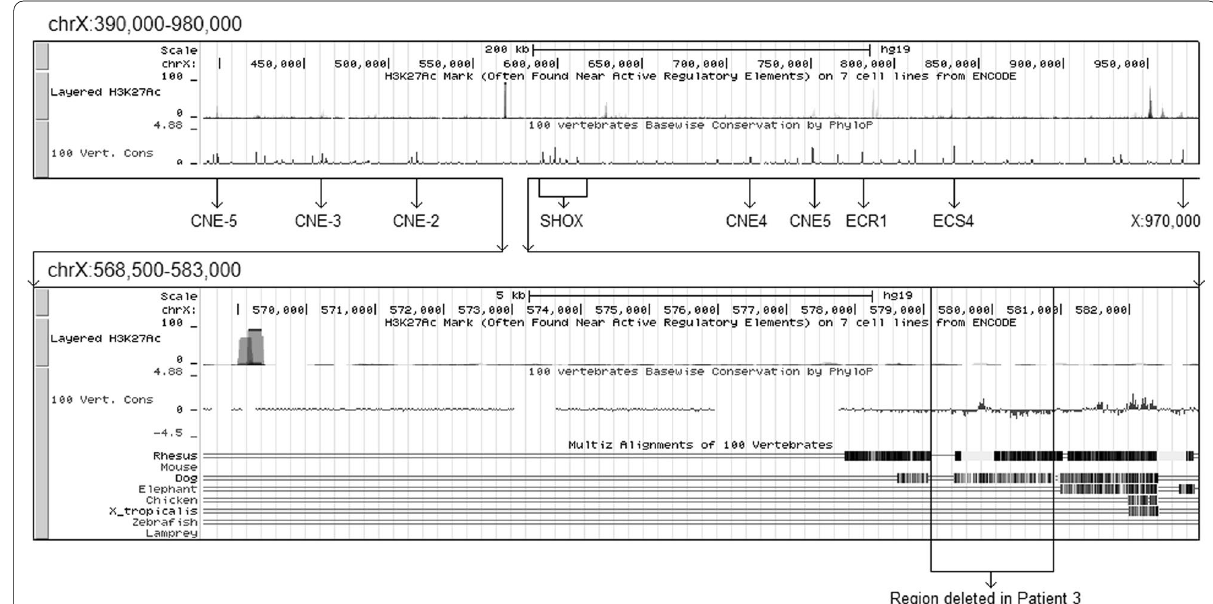
Fig. 3 UCSC output showing the conservation and H3K27Ac mark predictions for the SHOX flanking regions (above), with a more detailed view (below) of the deleted region in Patient 3 (X:579,123–580,912), showing the conserved region at approximately X: 579,783–579,973 and the E33, E41, E44 and E47 datasets [31] which show the H3K27 acetylation enrichment in four different limb developmental